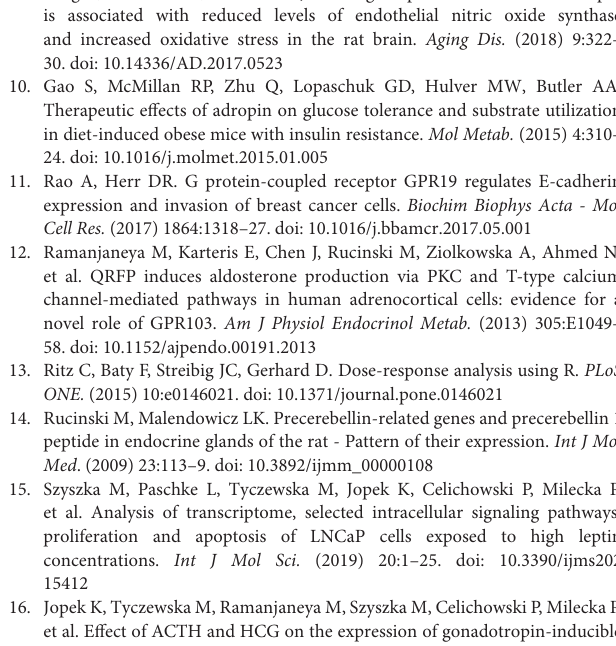
Supplementary Figure 1 | Expression of ARRDC3, JUN, HIST1H2BM and KIF20A genes in the HAC15 cell line after 24h of incubation with ACTH, forskolin and adropin versus control (untreated) cells. Real time QPCR study ( N = 4/group). Statistical differences were determined by the Mann–Whitney U non-parametric test compared to controls. ∗ p < 0.05; ∗∗ p <